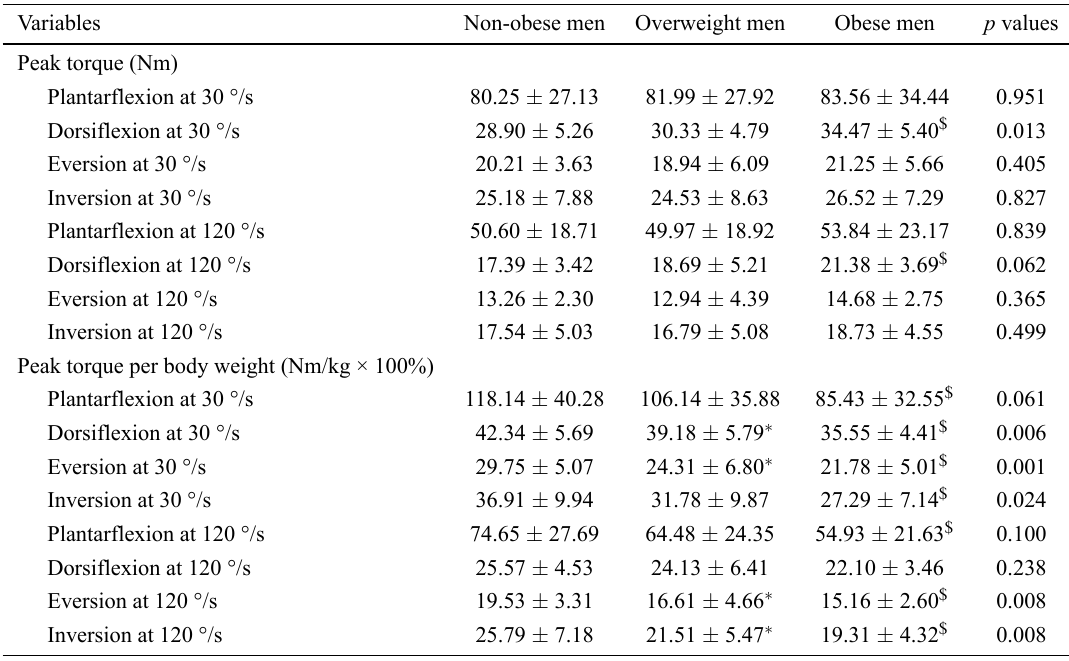
Table 4. Differences of the strength of muscles that move the ankle among different BMI groups by one-way ANOVA test followed by Bonferroni-Dunn post-hoc test.